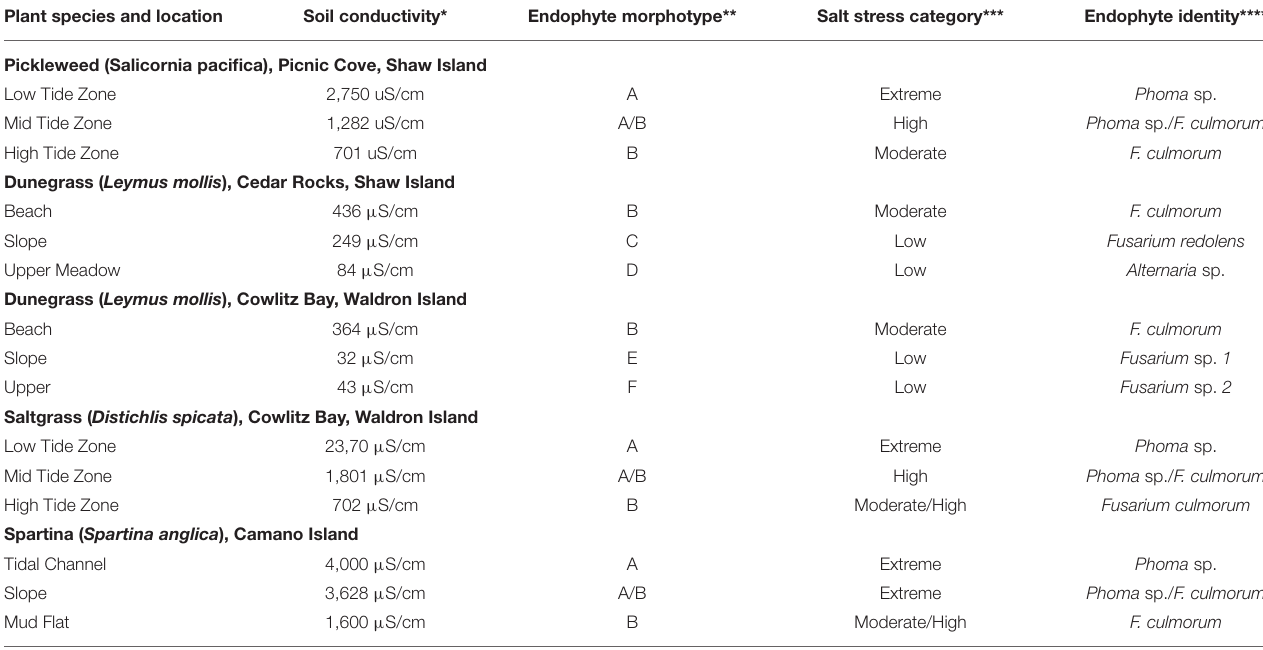
TABLE 1 | Dominant endophytes from plants growing across salinity gradients. Plant species and location